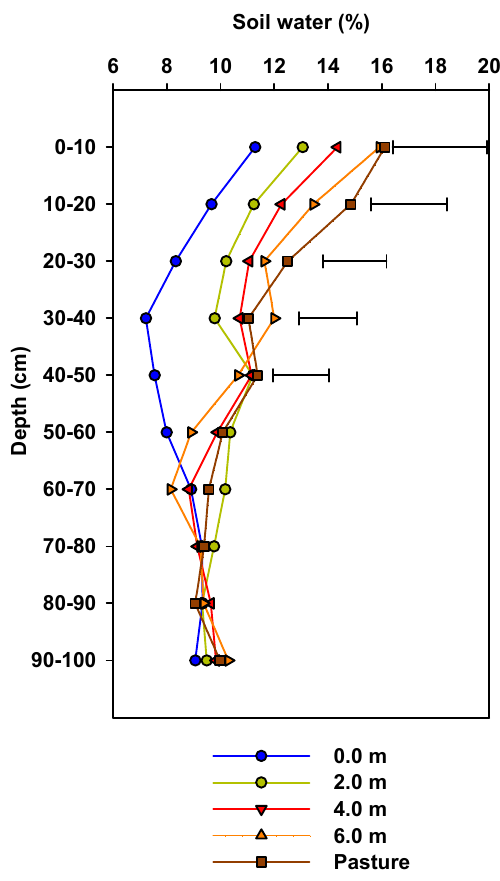
Figure 4. Average soil water content in the 2013–2015 period as a function of sampling location: 0.0 (planting row), 2.0, 4.0, and 6.0 m from the Eucalyptus tree rows and in monoculture pasture. The bars indicate LSD (0.05) values for locations with significant differences.